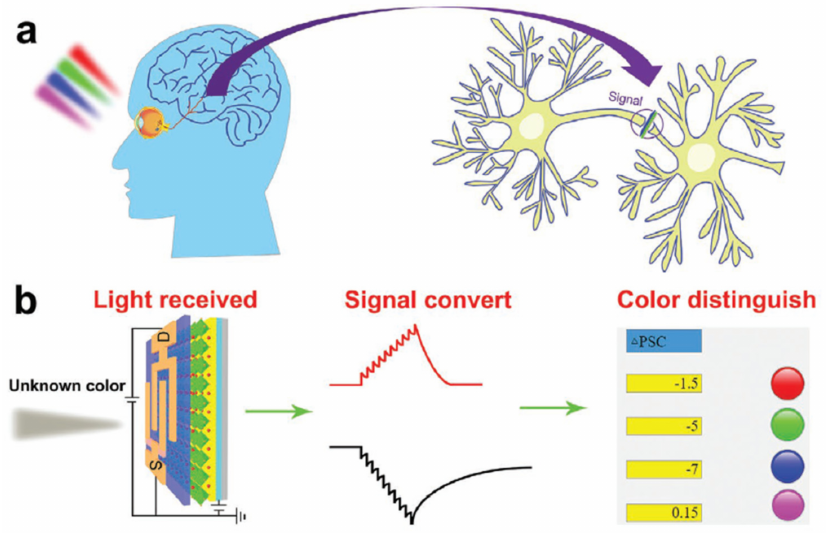
Figure 23. ( a ) Schematic of human visual system, ( b ) process of light receiving, signal converting, and distinguishing of different colours. Reprinted with permission from ref. [174]. Copyright 2021 John Wiley &